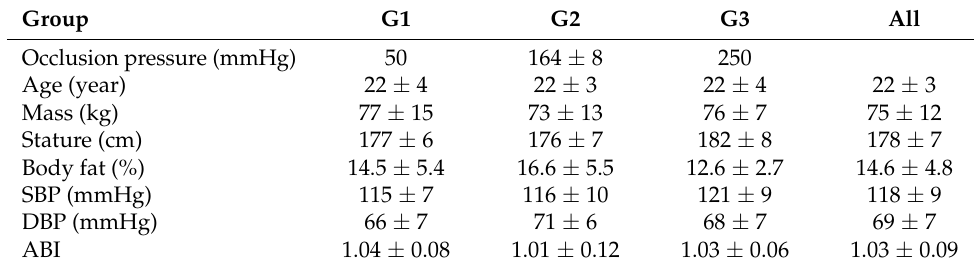
Table 1. Participant